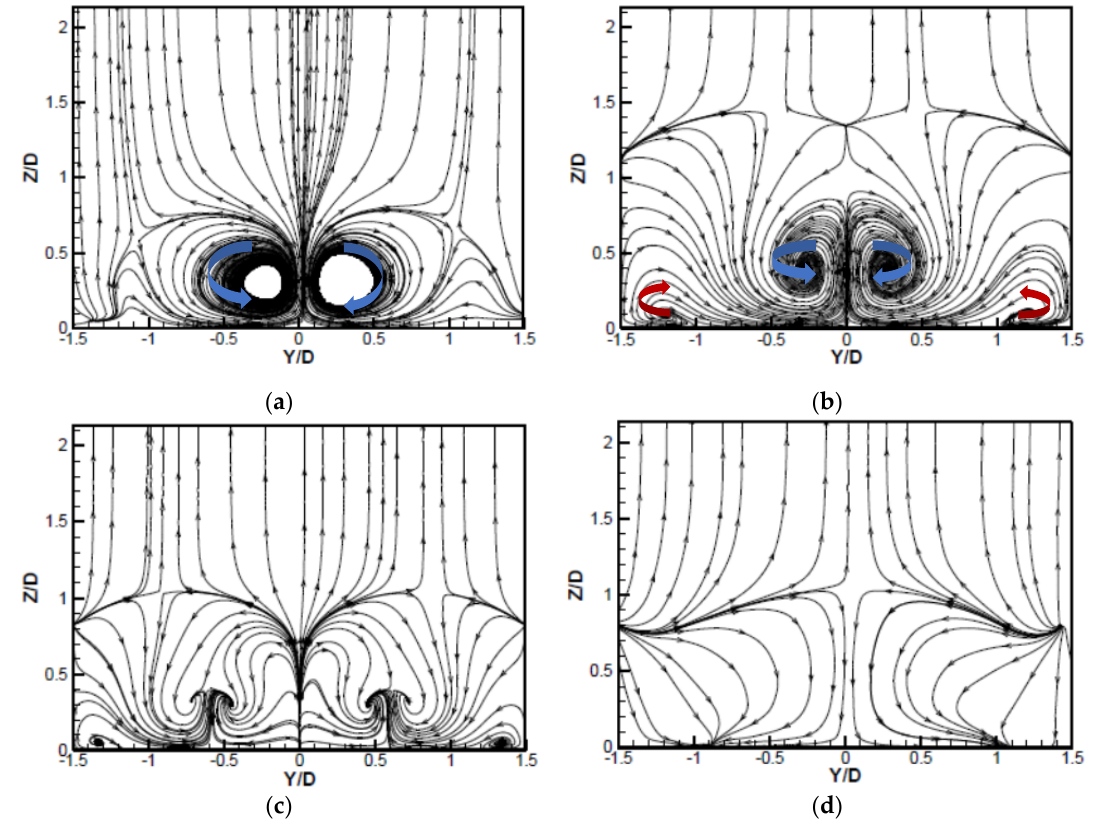
Figure 5. Streamline distributions over the surface X / D = 5 at M = 0.5. ( a ) CYL; ( b ) CIR_CRA; ( c ) CRA1; ( d ) CRA2. The contours of non-dimensional temperature over the surface X / D = 5 at M = 0.5 are shown in Figure 6. The coolant core is just above the wall surface for the CYL hole, and the coolant is attached to the wall surface. Because the additional anti-kidney-shaped vor- tex pair aside for the CIR_CRA hole has limited influence on the entire flow field, the non- dimensional temperature distribution is similar to that for the CYL hole. Compared with the CYL hole, the non-dimensional temperature contour shows a flat distribution, mainly attributed to the strong and large-scale anti-kidney-shaped vortex pair for the CRA1 and CRA2 holes. Comparatively, more coolants for the CRA2 hole are dragged sideways, and even non-dimensional temperature is distributed along the lateral span.